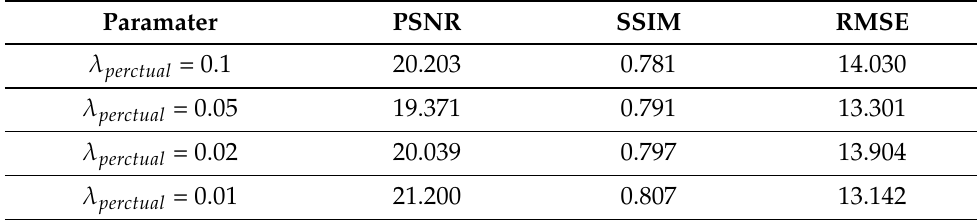
Table 6. Ablation results of paramater of λ perctual on the UIEBD-Snow dataset.